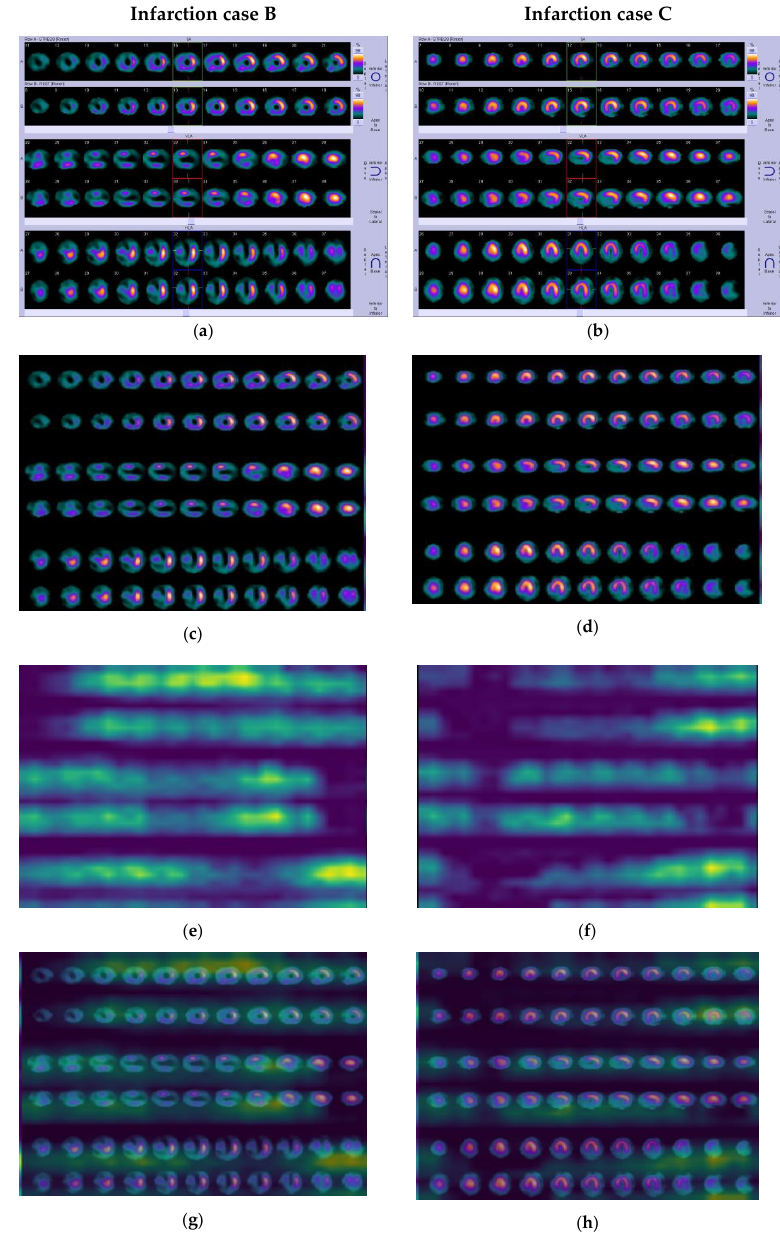
Figure A3. ( a,b ) Initial SPECT MPI image; ( c,d ) processed image; ( e,f ) heatmap; and ( g,h ) visualized results generated by Grad-CAM for infarction cases.